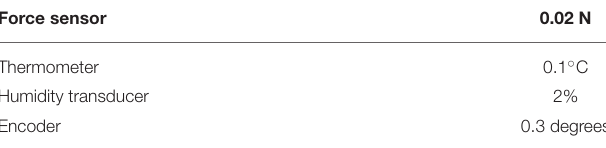
of the force sensor position relative to the lever was 0.1 mm, TABLE 6 | Accuracy of measuring